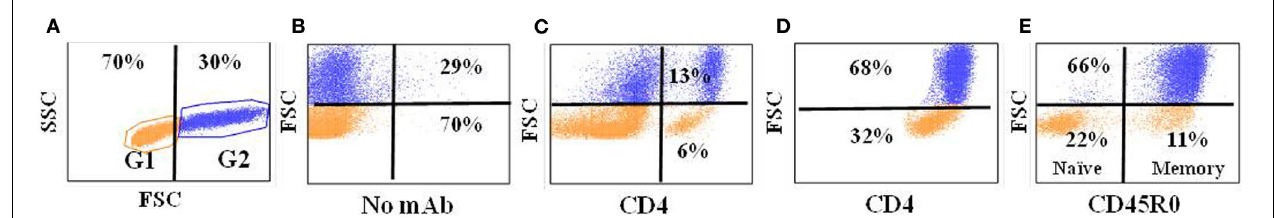
FIGURE 3 | Gating strategy used to analyze the proliferative response of peripheral blood mononuclear cells (PBMC) ex vivo following stimulation with live Map . Representative CD4 profiles obtained with PBMC from a calf inoculated/vaccinated with (cid:2) relA and challenged with wild type Map . (A) Selective gates were placed on resting/unstimulated cells (G1)